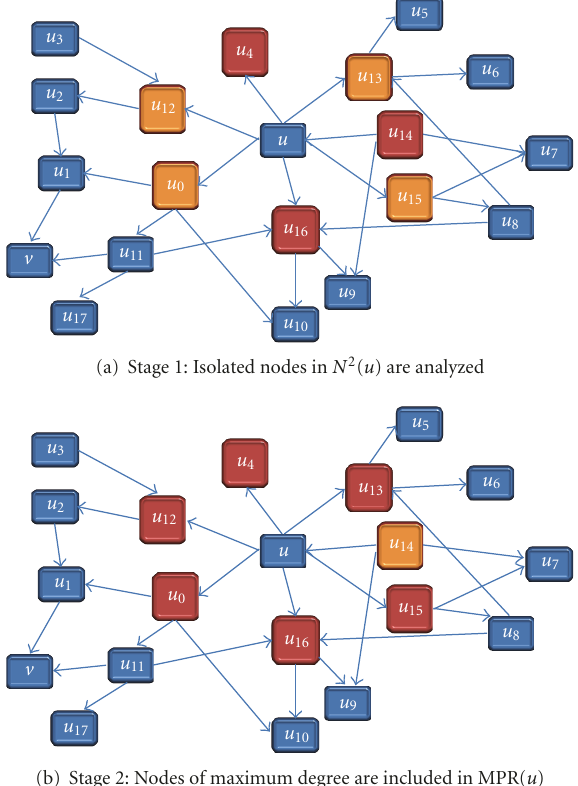
Figure 2: Stages in MPR-OLSR.